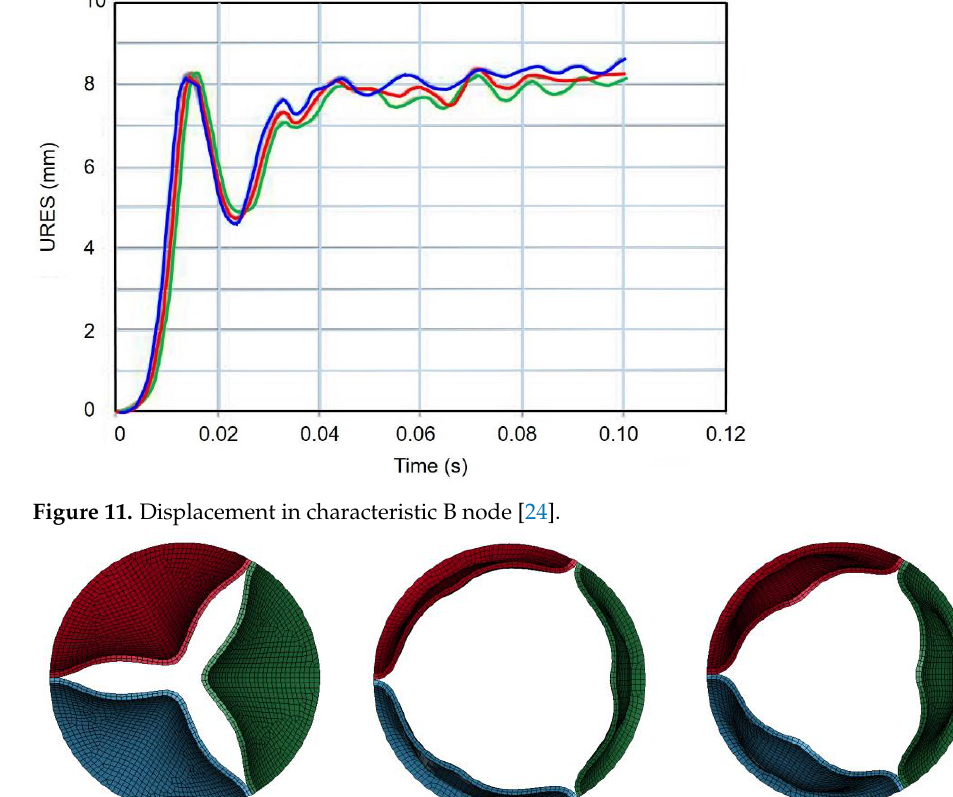
Figure 10. Displacement in characteristic B node in the present study.